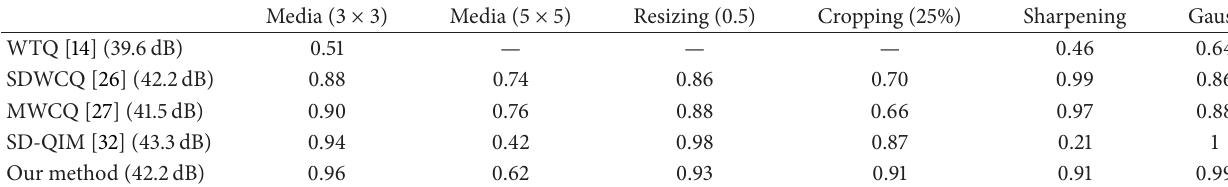
Table 4: Comparisons of robustness against incidental